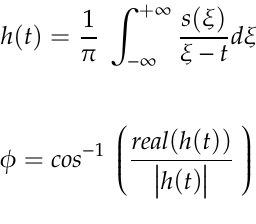
Figure 26. Mean TKE distribution. ( a ) Clean flow; ( b ) Cylinder wake